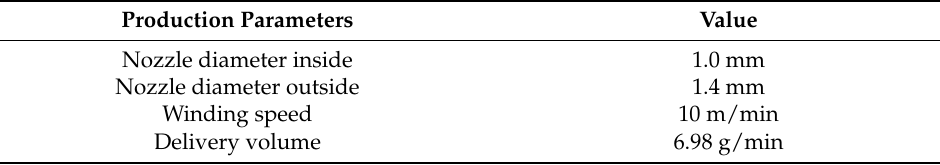
Table 2. Parameters of extruder for production of FL-LI coated yarn.